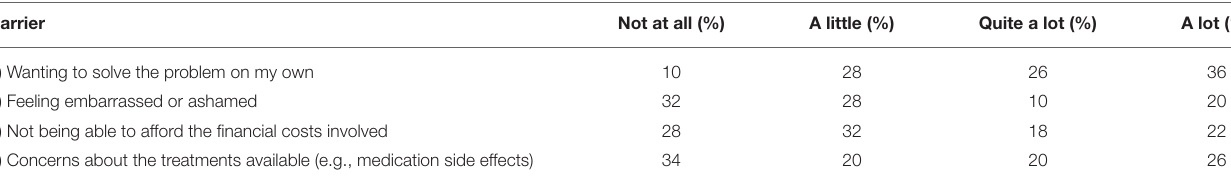
TABLE 3 | A description of the four most endorsed barriers to help-seeking in the study sample.